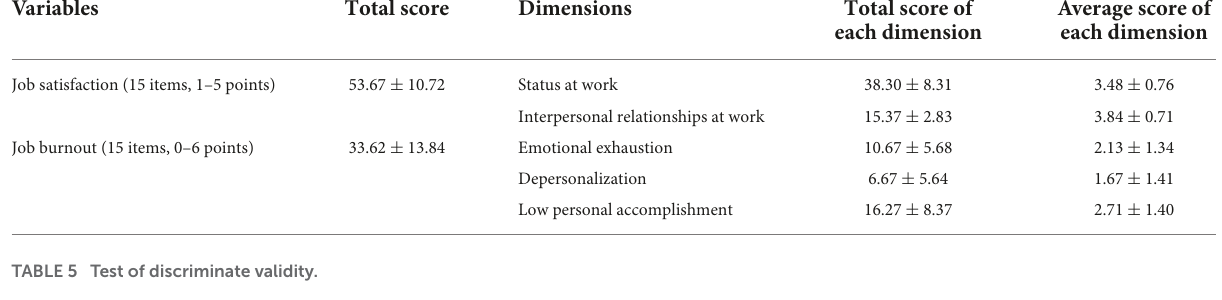
TABLE 5 Test of discriminate validity.